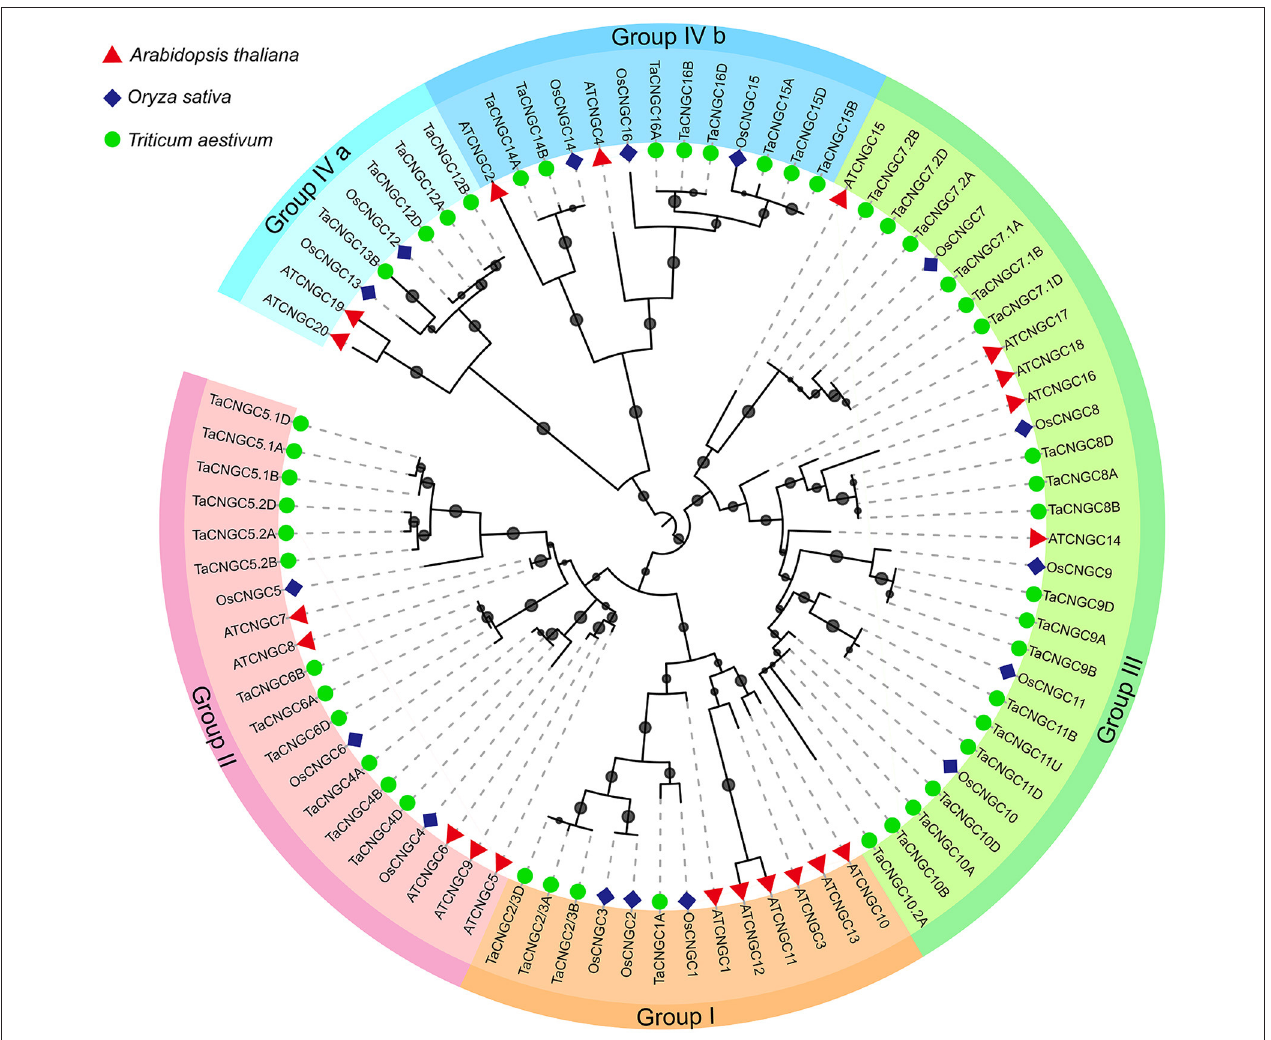
FIGURE 3 | Phylogenetic relationship of TaCNGCs, OsCNGC, and AtCNGC proteins. The maximum likelihood (ML) tree under the Le_Gascuel_2008 model (LG) model was constructed by the MEGA6 software. The midpoint rooted base tree was drawn using Interactive Tree of Life (IToL) Version 3.2.3. Scale bars correspond to 0.1 amino acid substitutions. Different groups were marked by different colors, and the CNGCs from wheat, rice, and Arabidopsis were distinguished with different shapes and